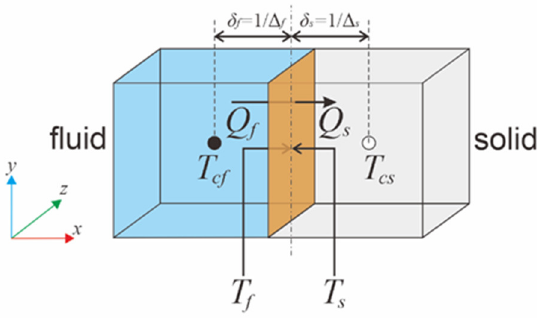
Figure 4. Schematic of fluid and solid cell at the interface.